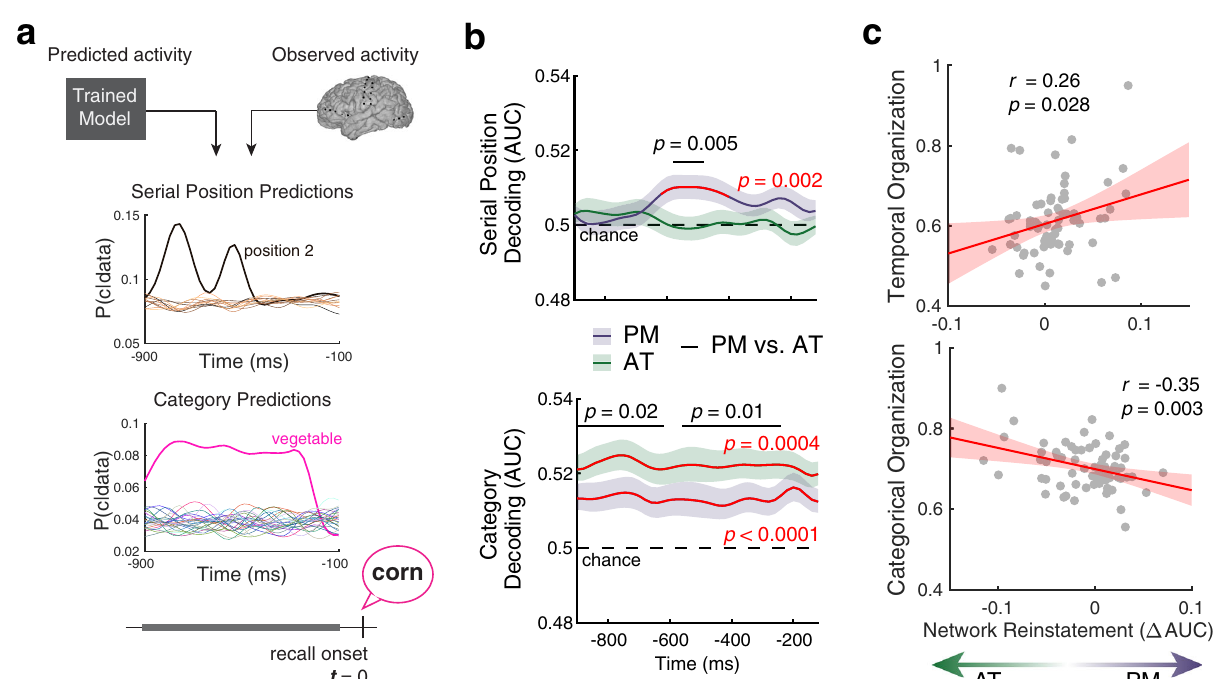
Fig. 3 Reinstatement of content and context information during memory search. a Simulated reinstatement analysis. Models trained during encoding predicted the serial position (top) or category (bottom) of the upcoming recall. b Decoding performance from reinstated patterns of neural activity within each network. Top, the serial position model revealed transient context reinstatement within the PM network. Bottom, the category decoding model revealed greater content reinstatement within the AT than the PM network. Signi fi cant differences in reinstatement between the two networks are indicated in black. Red lines highlight timepoints with above chance decoding, p < 0.05, FWER corrected (two-sided permutation t test). c Relationship between network reinstatement and organization of recall sequences along temporal and categorical dimensions. Each point denotes an individual subject. Top, greater context reinstatement in the PM network was associated with increased temporal organization. Bottom, greater content reinstatement in the AT network was associated with greater category organization. Uncorrected p values from two-sided Student ’ s t tests are displayed ( b , c ), after averaging over signi fi cant timepoints (FWER corrected, b ). For all tests, n = 69 subjects (indicated by points in c ). Shaded regions denote mean ± 1 SEM. Source data are provided as a Source Data fi